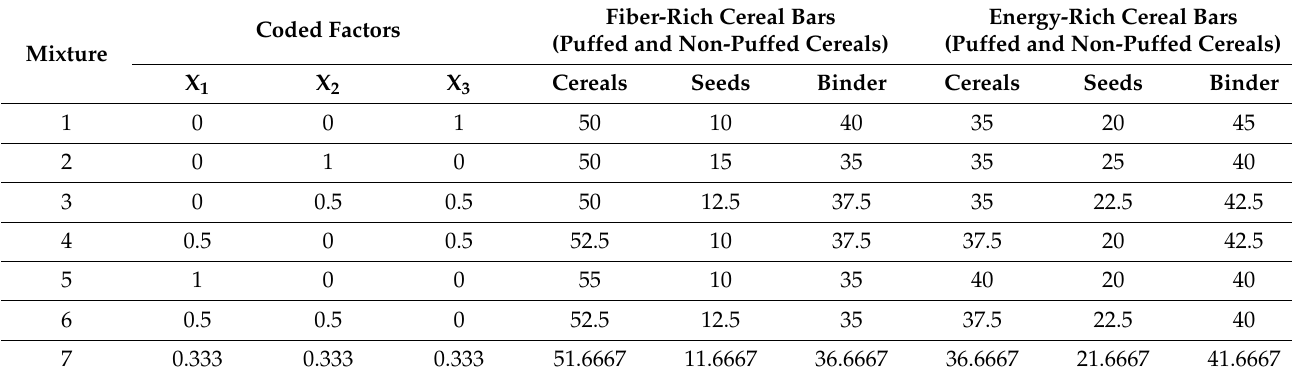
Table 1. Mixture design of three main ingredients for each type of gluten-free cereal